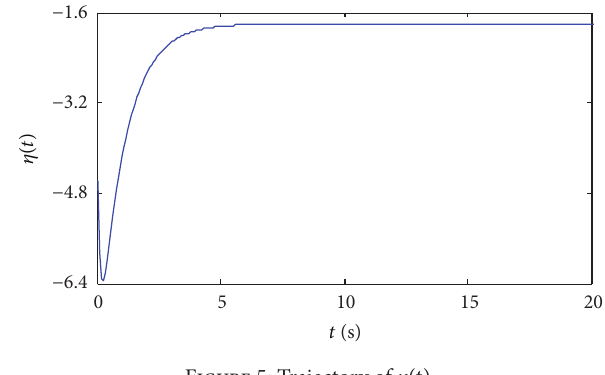
Figure 5: Trajectory of 𝜂(𝑡)